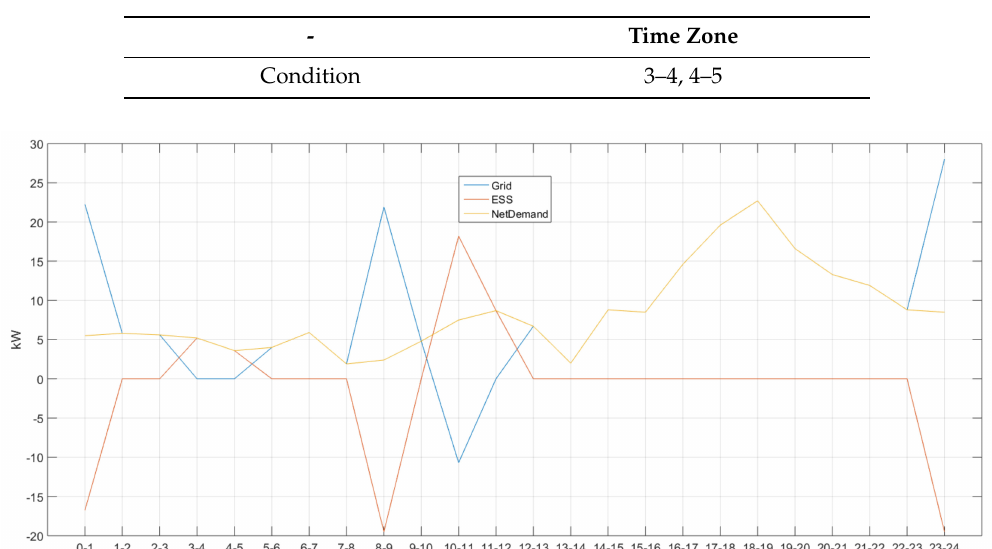
Table 9. Net Zero operating condition.